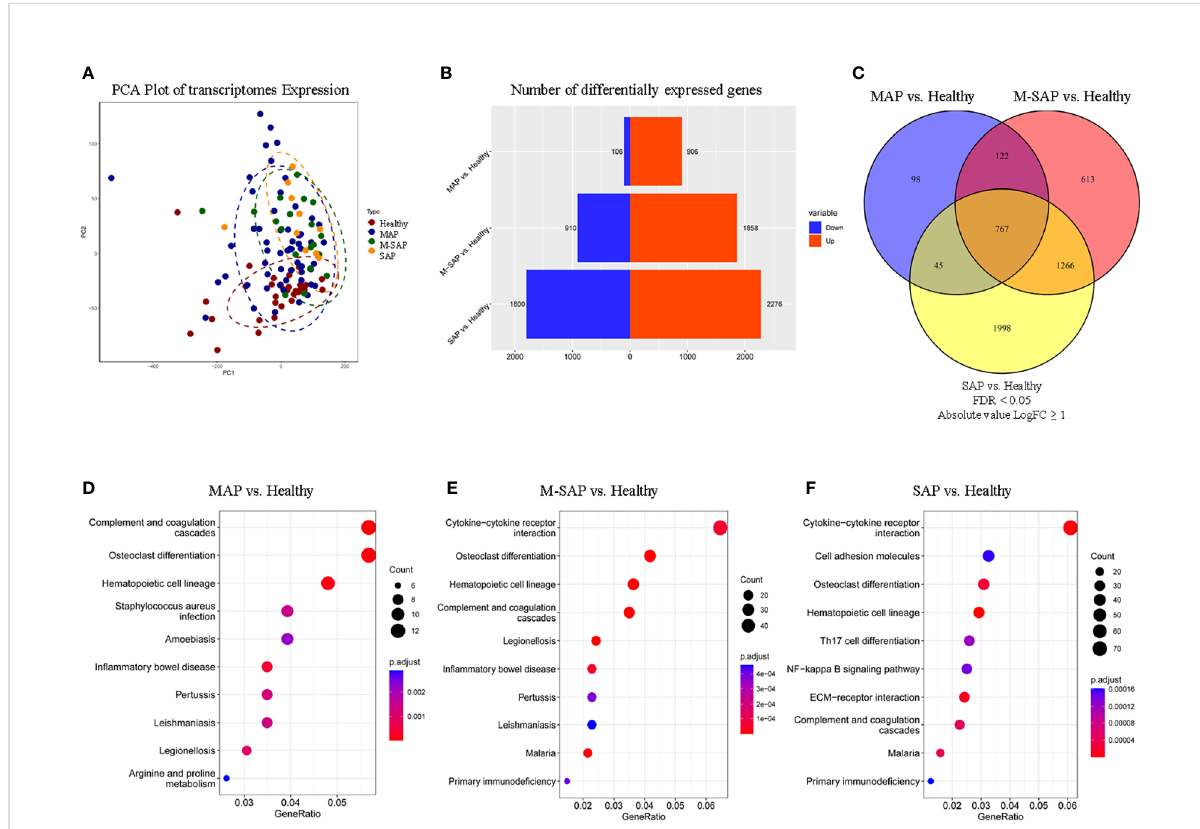
FIGURE 1 Shared DEGs and pathways of AP of different severity levels. (A) Principal component analysis of sub-subjects with MAP, M-SAP or SAP and healthy controls. (B) Distribution of the number of DEGs between each severity level of AP and healthy controls. The red rectangle indicates upregulated genes, and the blue rectangle indicates downregulated genes. (C) Venn diagram depicting the overlapping DEGs in each severity group compared with a common set of healthy groups. (D – F) Pathway enrichment analysis for three severity levels of AP and healthy controls using KEGG analysis. Only the top 10 signi fi cantly enriched pathways after sorting by the Bonferonni adjusted P value were selected. Dots represent signi fi cant pathways, and all of them were sorted and colored by adjusted P